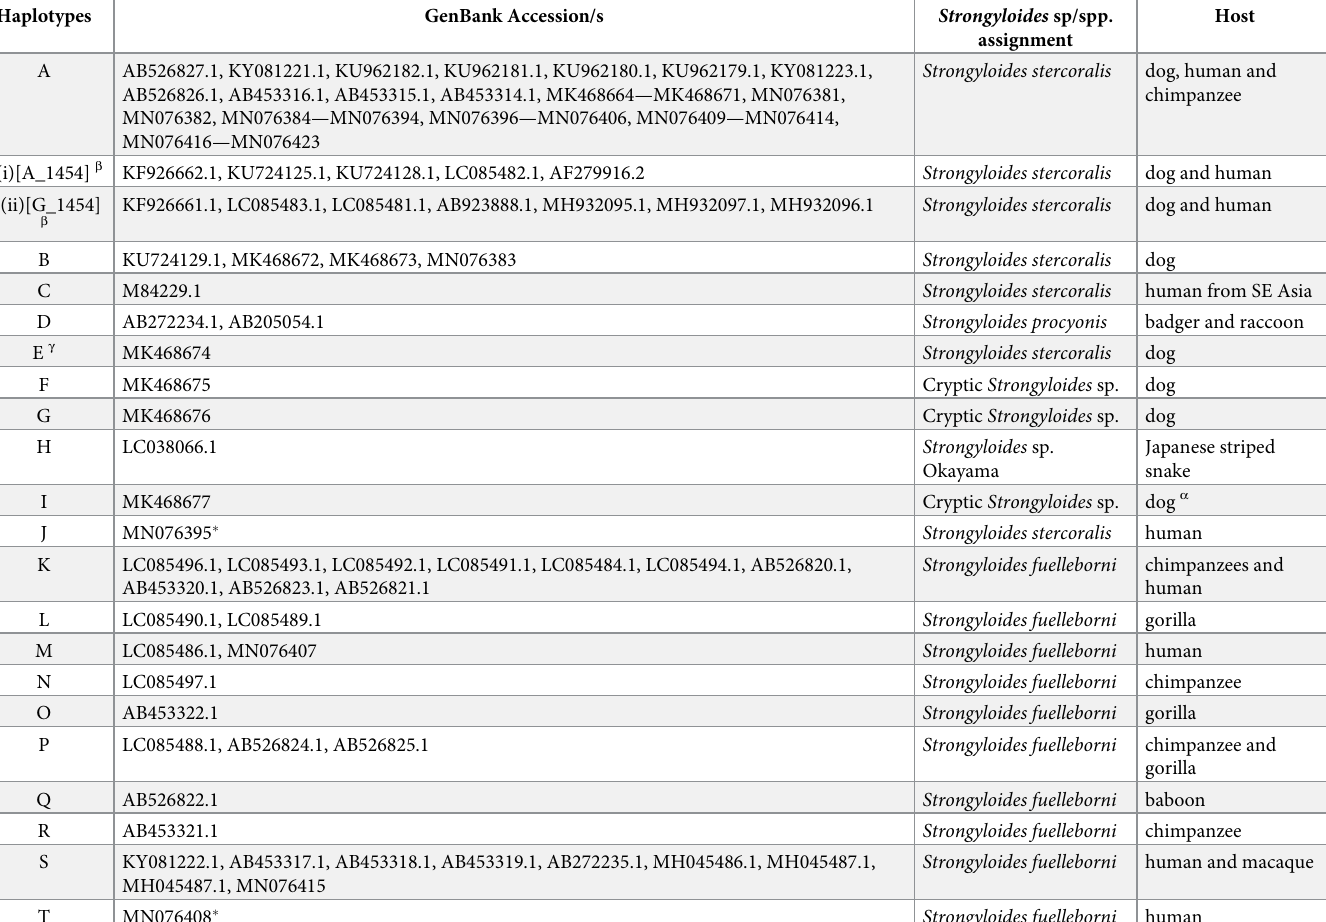
Table 3. HVR-IV haplotypes assigned to Strongyloides spp. as part of this typing scheme.